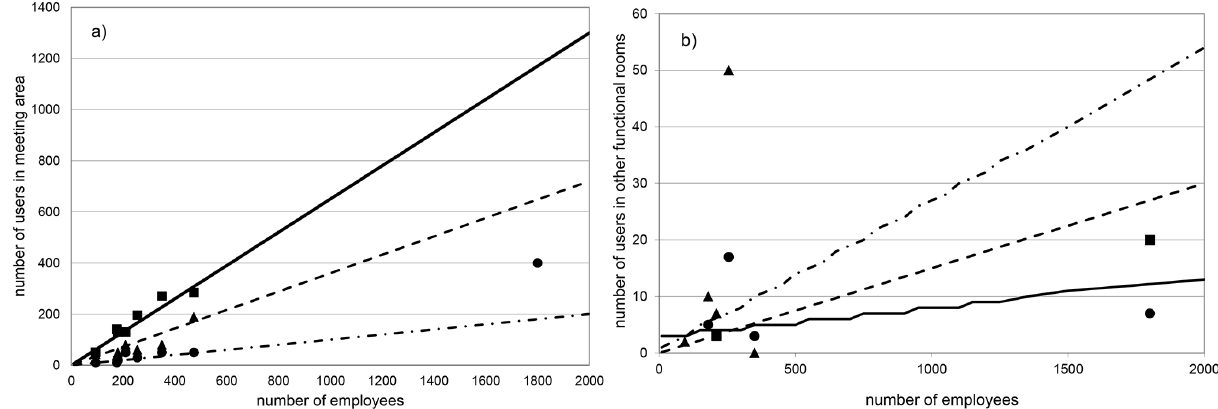
Figure 5. Number of users in the standardised o ffi ce of design-demand-equations (lines) and in surveyed o ffi ces (data points) in the dominant functional room of o ffi ces, meeting area (a) with male employees (- and (cid:4) ), female employees (- - and N ) and visitors (-.- and • ) and in other functional rooms (b) with kitchen personnel (- and (cid:4) ), employees using the fitness room (- - and N ) and cleaners (-.- and •